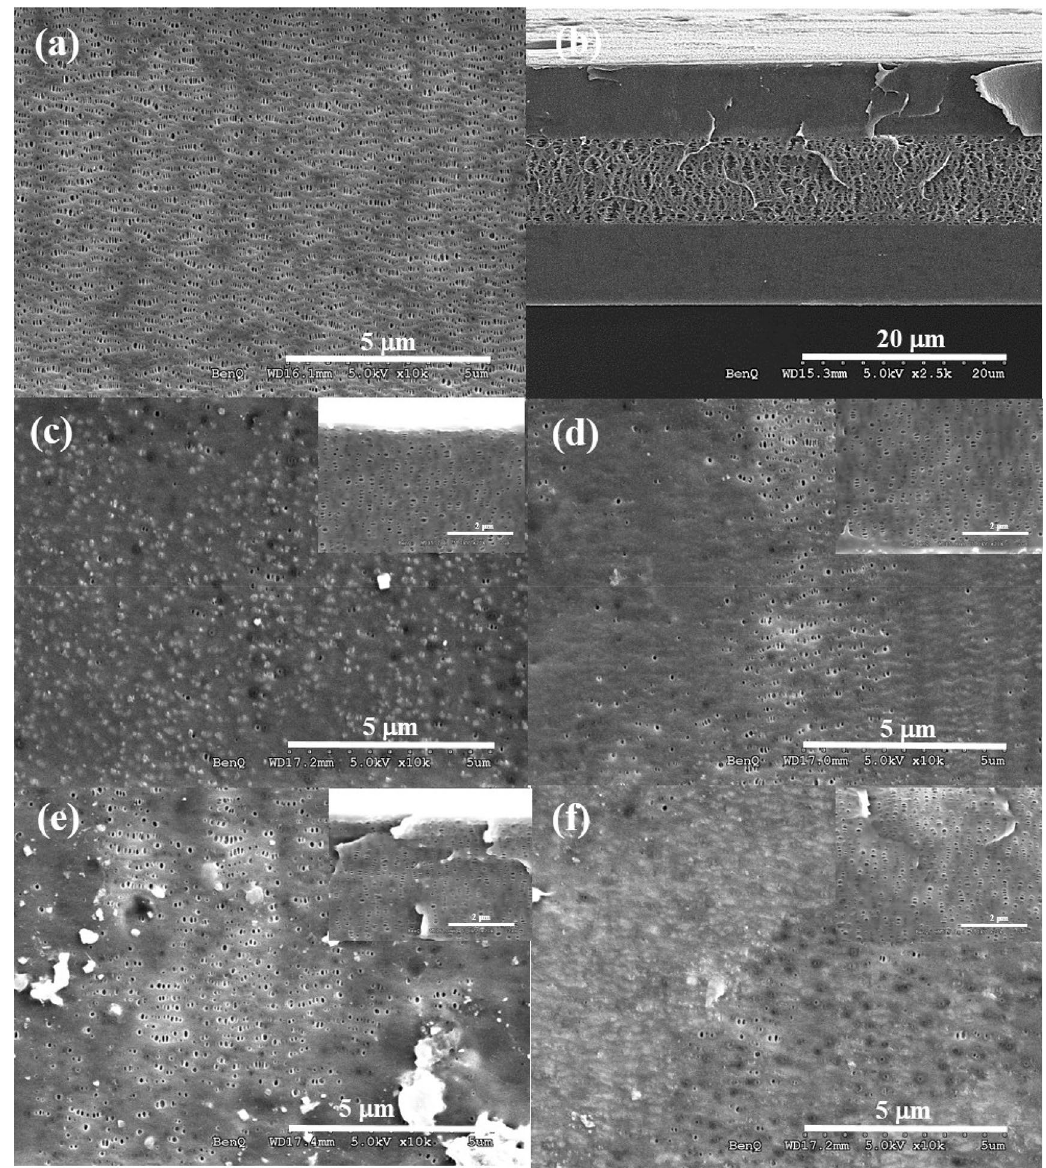
Figure 3. SEM images of trilayered PP/PE/PP separator: ( a ) pristine top surface; ( b ) pristine cross-section; ( c , e ) the cathode side image after the rate rest at 1.0 C and 0.025 C for 5 cycles, respectively; ( d , f ) the anode side image after the rate rest at 1.0 C and 0.025 C for 5 cycles anode side, respectively. Inset in ( c – f ) shows the corresponding cross-section